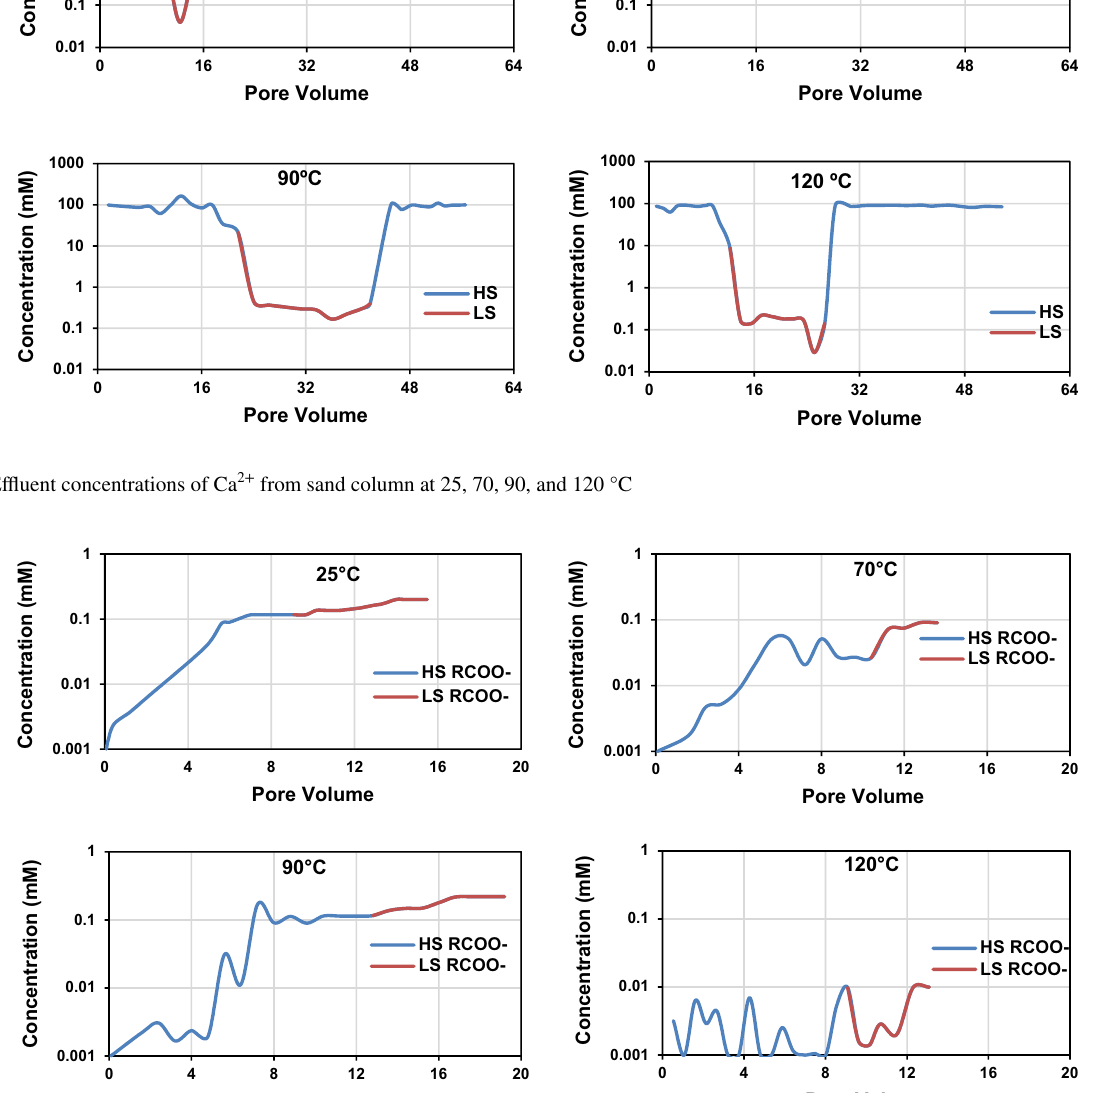
increased the pH gradients decreased. The gradients of pH were 2.51, 2.44, 2.09, and 2.04 at 25, 70, 90, and 120 °C, respectively. ICP-OES shows that about 0.32, 0.37, 0.32, and 0.16 µmole Ca 2+ desorbed from silicate surface at 25,